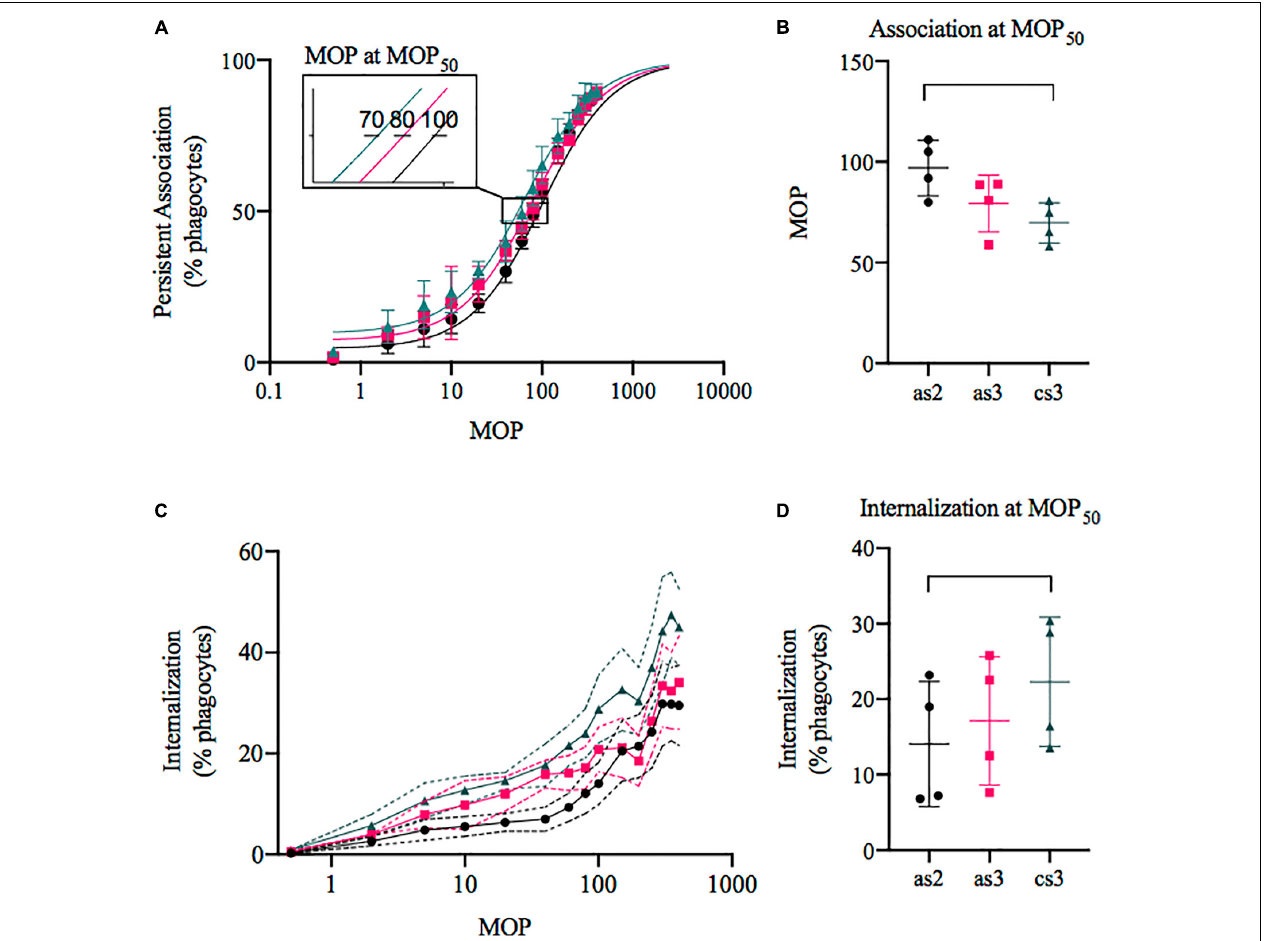
FIGURE 4 | Phagocytosis of S. dysgalactiae isolated from the patient with three bacteraemia episodes with seroconversion. The bacteria were opsonised with the acute serum from episode 2 (black, as2), 3 (pink, as3), or the convalescent serum (green, cs3) and then incubated with the THP-1 cells. Data was acquired through flow cytometry and is presented as mean ± SD ( C: visualised with SEM), n = 4. (A,C) The percentage of THP-1 cells associated (A) or internalising (C) with at least one prey plotted on the y -axis and the multiplicity of prey (MOP) on the x -axis. (B) The MOP to evoke 50% association (MOP 50 ) was 70 ± 10.0, 79 ± 14.1, and 97 ± 13.8 (cs3, as3, and as2). (D) At MOP 50 the percentage of THP-1 cells internalising was 14 ± 8.3, 17 ± 8.5, and 22 ± 8.6 (as2, as3, and